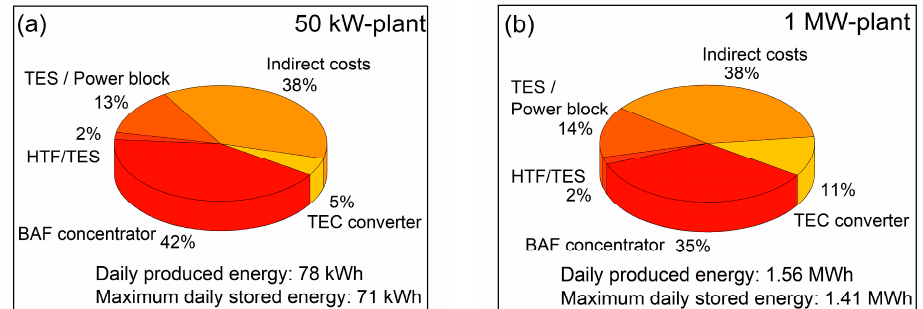
Figure 6. Cost break-up of a 50 kW ( a ) and 1 MW ( b ) CSP plant based on a BAF concentrator with TEC integration and 6 h of thermal energy storage. The maximum daily stored energy